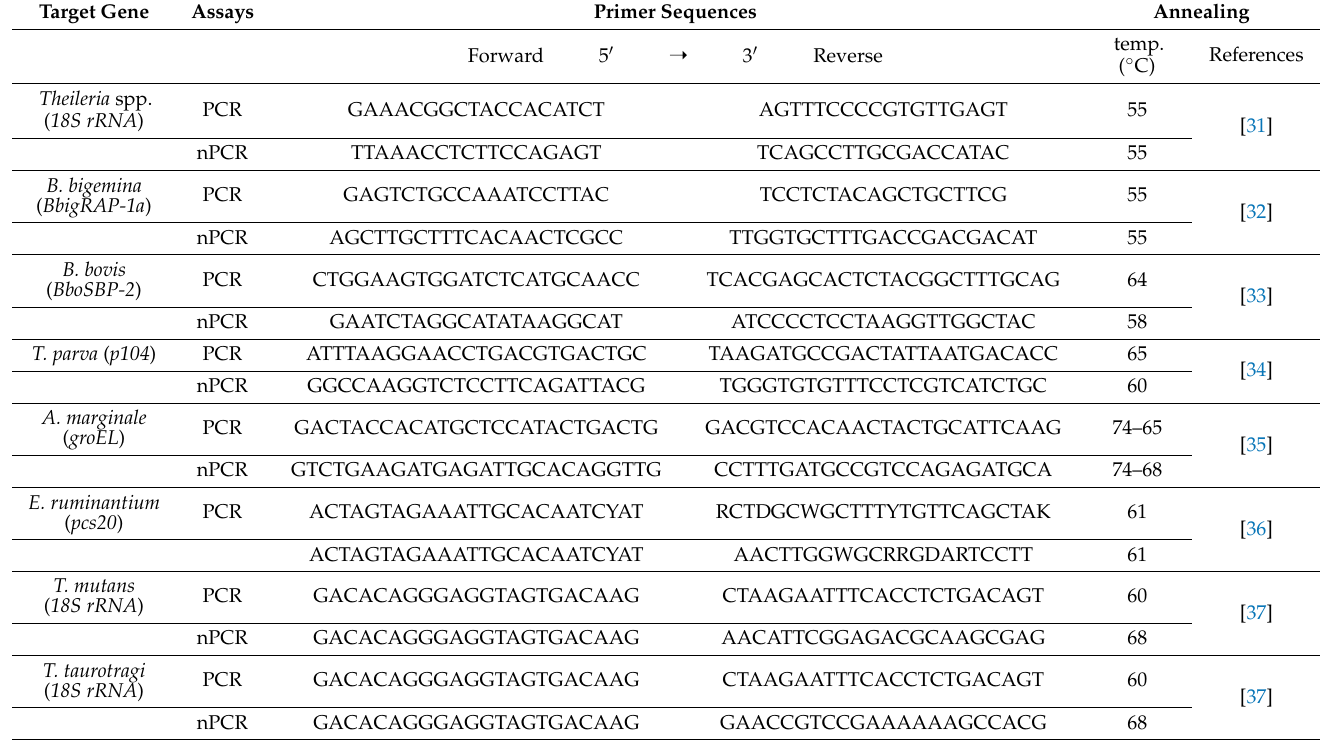
Table 1. List of primers used in the